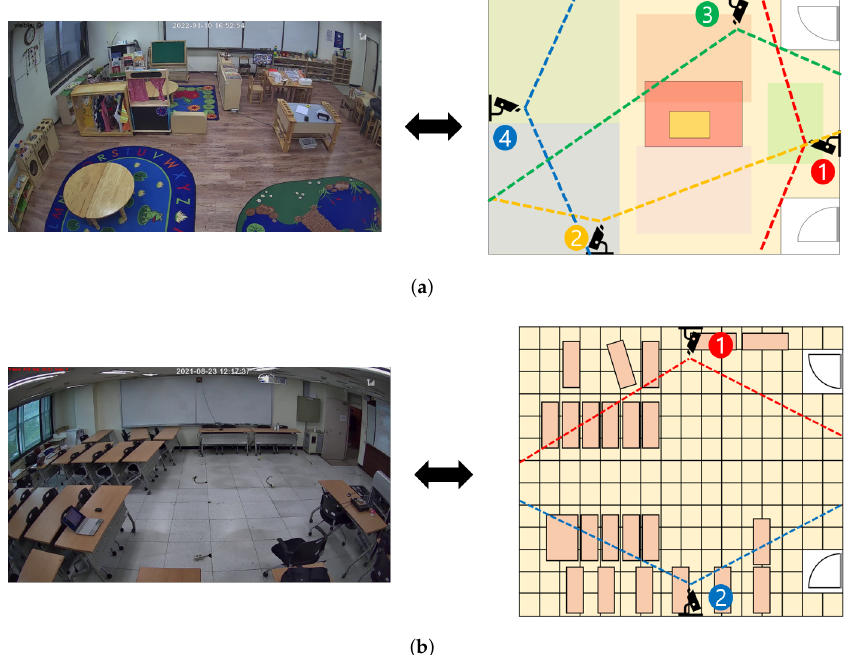
Figure 4. The testbeds and projected maps at two different locations ( a ) with four cameras and ( b ) two cameras,